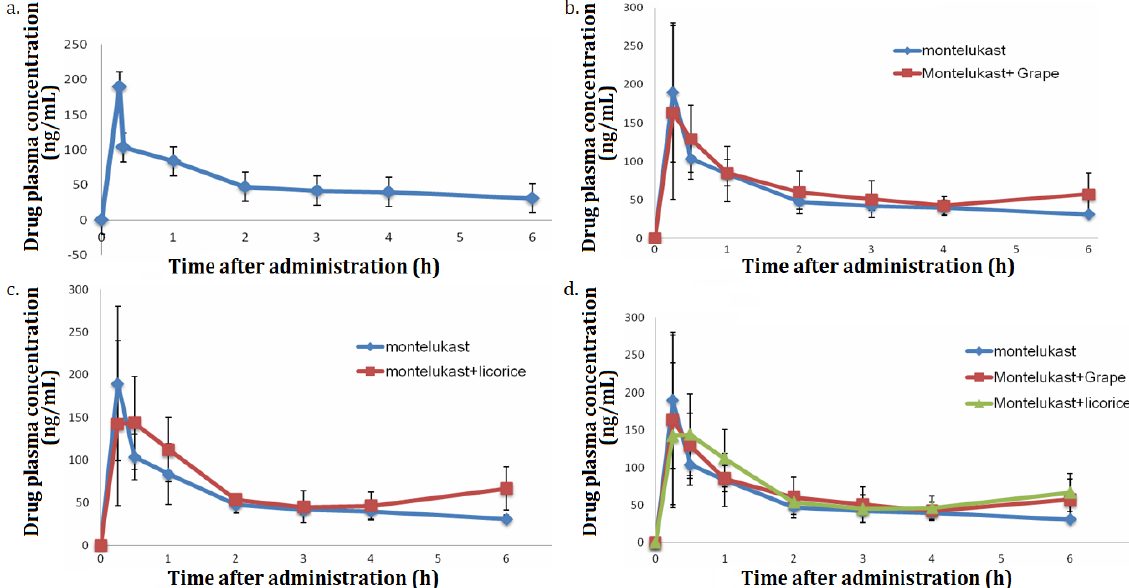
Figure 4. a. Rat plasma profile showing the changes in mean serum montelukast concentration with time after drug administration, each data point represents the mean ± SEM (n=4); b. Rat plasma profile showing the changes in mean serum montelukast concentration with time after drug administration, comparing montelukast with grape juice and solitary drug use, each data point represents the mean ± SEM (n=4); c. Rat plasma profile showing the changes in mean serum Montelukast concentration with time after drug administration, comparing Montelukast with licorice juice and solitary drug use, each data point represents the mean ± SEM (n=4); d. Rat plasma profile showing the changes in mean serum Montelukast concentration with time after drug administration comparing combined and solitary drug